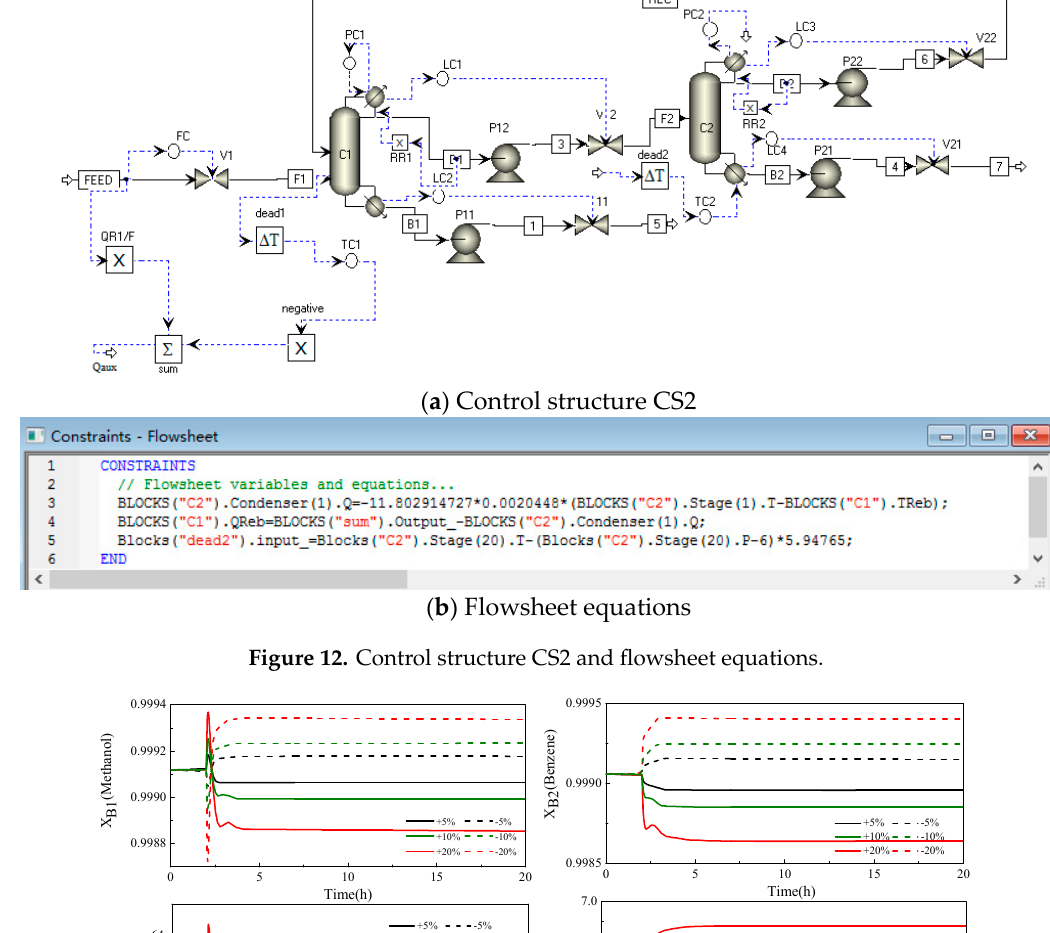
Figure 12. Control structure CS2 and flowsheet equations.